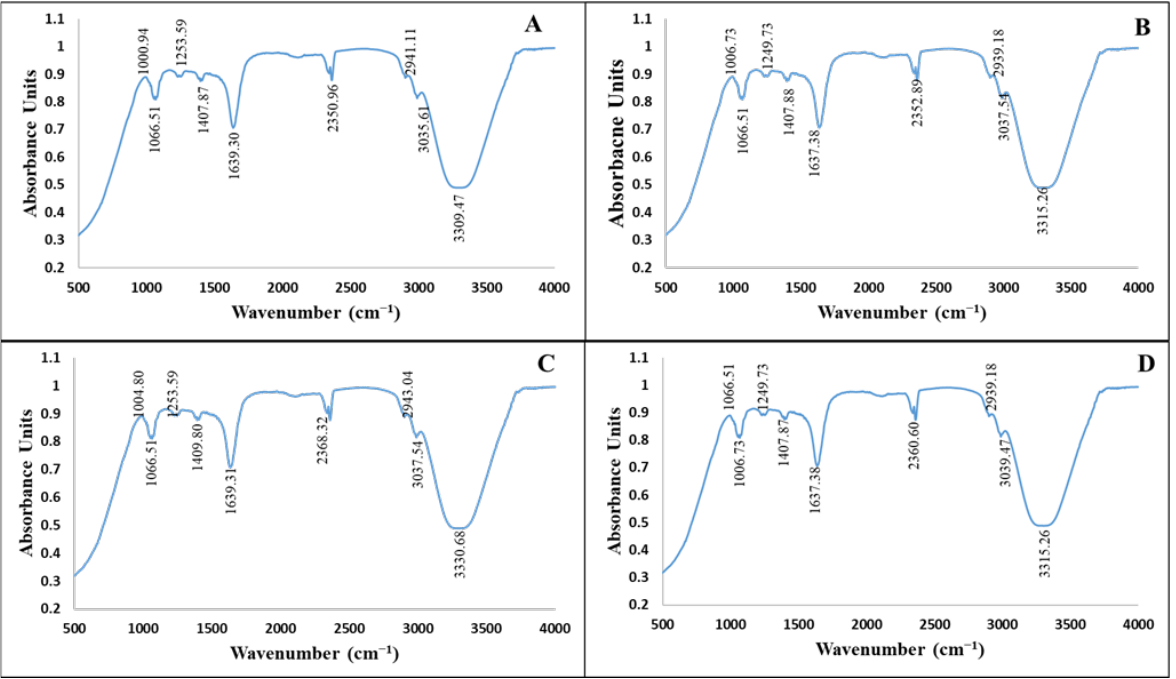
Figure 2. FTIR spectra of ZnONPs. ( A ) Casuarina equisetifolia leaf extract ( B ) CE-ZnONPs ( C ) CE-UV-A-ZnONPs ( D ) CE- UV-C-ZnONPs.